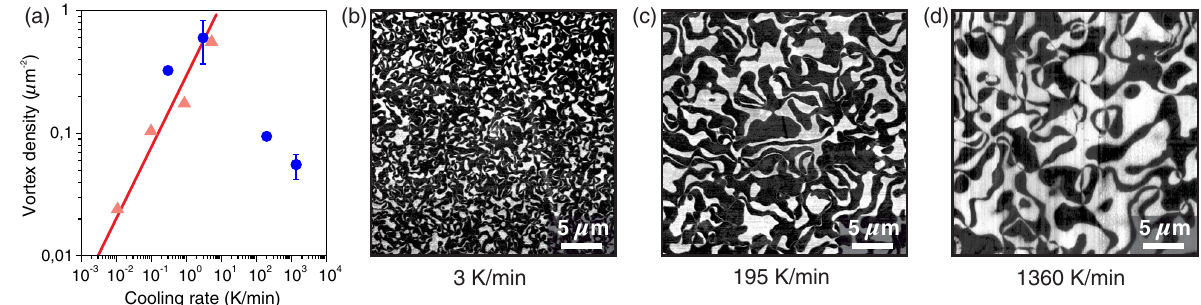
FIG. 4. (a) Areal vortex-core density as a function of cooling rate for slow cooling (red triangles, Ref. [45]) and fast cooling (blue circles, this work). Note the turnover in the cooling-rate dependence of the vortex-core density occurring at around 10 K = min . The red solid line is the result of our ab initio application of the Kibble-Zurek mechanism with parameters from first-principles calculations. samples after annealing cycles at different cooling rates. The (b)–(d) Distribution of ferroelectric domains in z -oriented YMnO 3 images, which are obtained using PFM on an area 30 (cid:3) 30 (cid:5) m 2 , reveal a striking ‘‘anti–Kibble-Zurek’’ behavior, with higher cooling rates leading to larger domains.